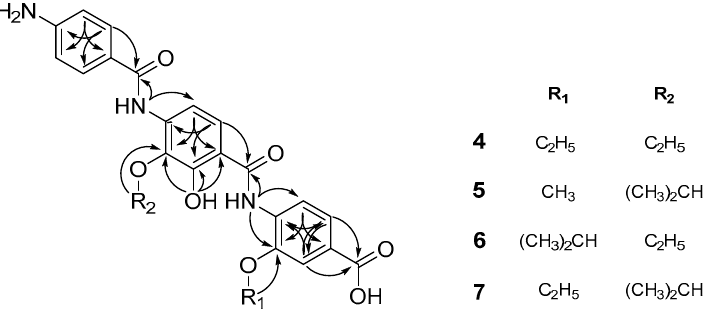
Figure 3. Key HMBC and COSY correlations of 4 − 7 .